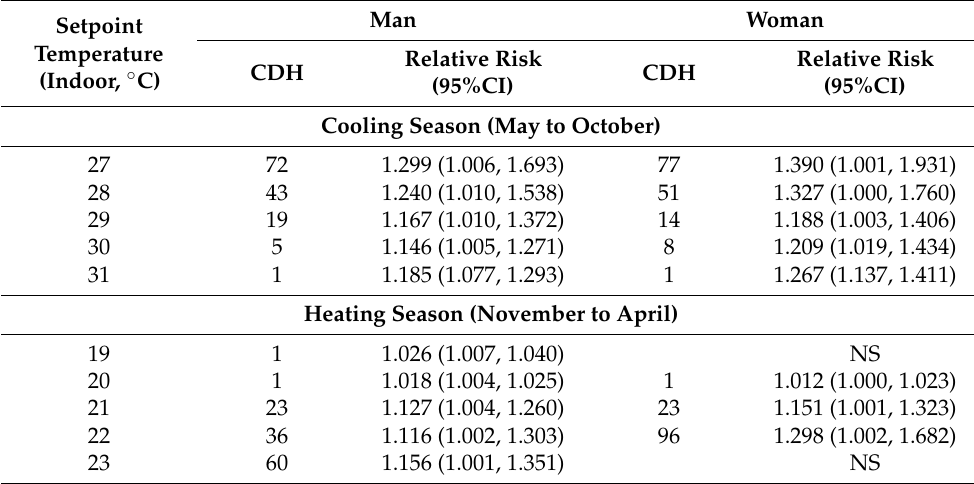
Table 4. Cooling and heating cumulative degree hours for infectious respiratory disease-related emergency department visits for older adults from 2006 to 2014 (gender stratified). Setpoint